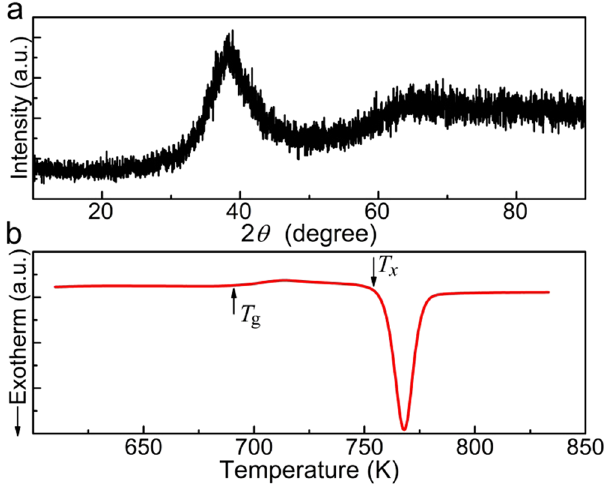
Figure 1. XRD pattern and DSC trace for Zr 50 Cu 44 Al 6 MG. ( a ) The XRD pattern for the as-cast Zr 50 Cu 44 Al 6 alloy shows broad and diffuse maxima, indicating its glassy nature. ( b ) The DSC (heating rate of 20 K/min) trace for the Zr 50 Cu 44 Al 6 MG clearly presents the glass-transition marked by T g and the crystallization onset marked by T x